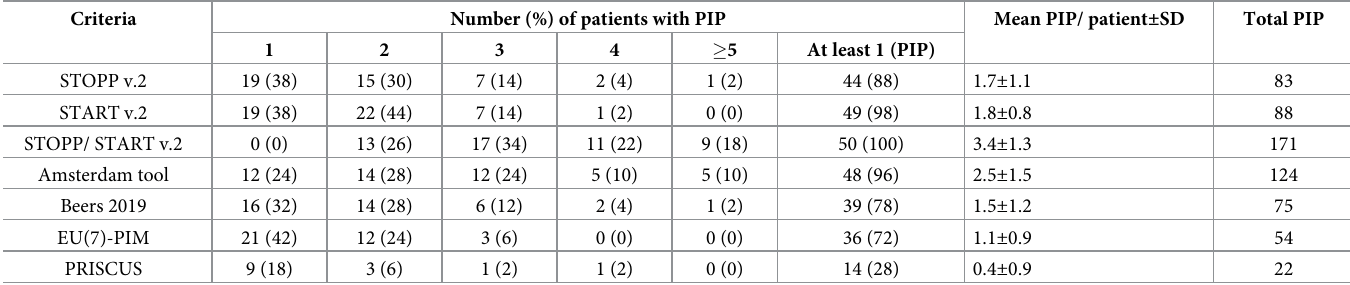
Table 2. The number (%) of patients with PIP, the mean number of PIP cases per patient ± SD and the total number of PIP cases identified by the different criteria. Criteria